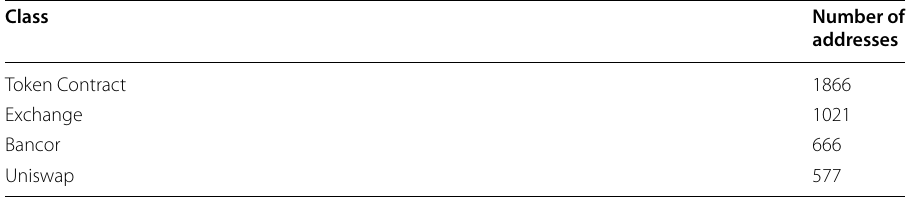
Table 3 Number of addresses belonging to each class of interest for our investigation